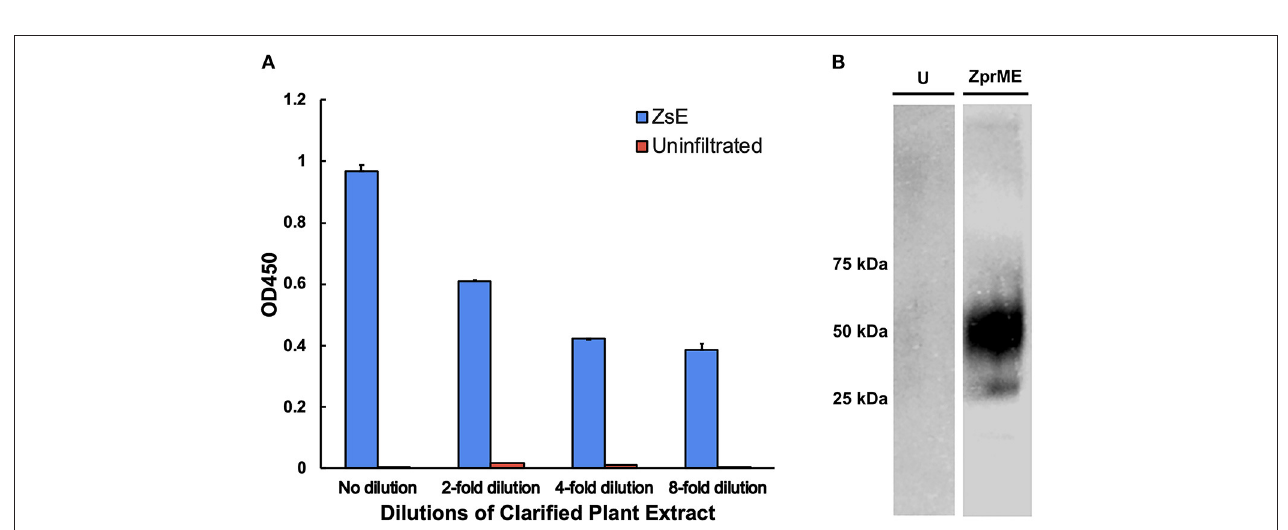
FIGURE 8 | Binding of c2A10G6 to ZIKV envelope glycoprotein. (A) Varying dilutions of clarified protein extract containing ZsE was directly bound to a polystyrene plate and probed with purified c2A10G6 to assess whether the antibody recognized the fusion loop epitope. Bound antibody was detected with goat anti-human IgG (kappa only) HRP conjugate. An uninfiltrated negative control was included to assess the level of any non-specific binding to native plant proteins. (B) The ability of c2A10G6 to recognize the fusion loop epitope was analyzed via a western blot. Clarified protein extracts containing ZprME or an uninfiltrated control were probed with purified c2A10G6 and detected with HRP-conjugated goat anti-human IgG